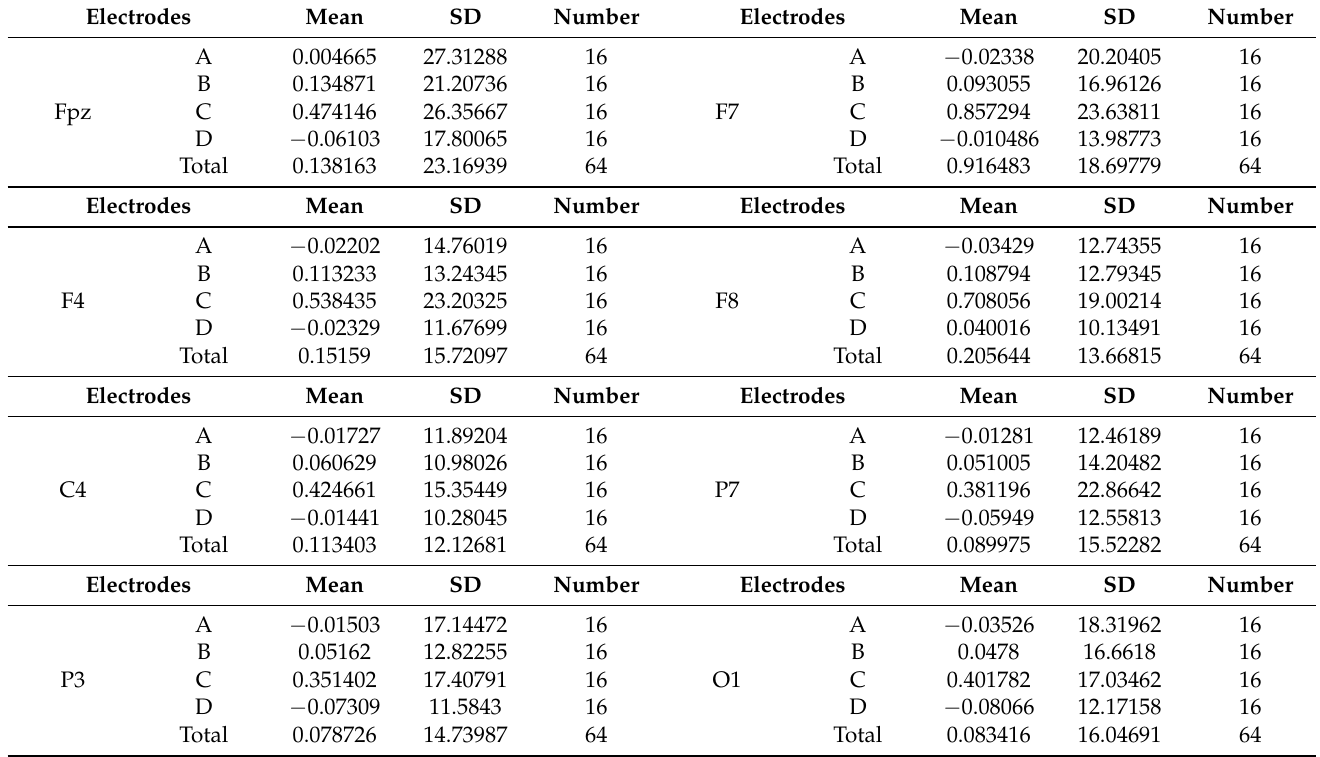
Table 5. Analysis of the mean value of the amplitude of each electrode: A refers to C-life Senior Care APP; B refers to Senior Living APP; C refers to Senior Care Manager APP; D refers to Smart Aging APP.